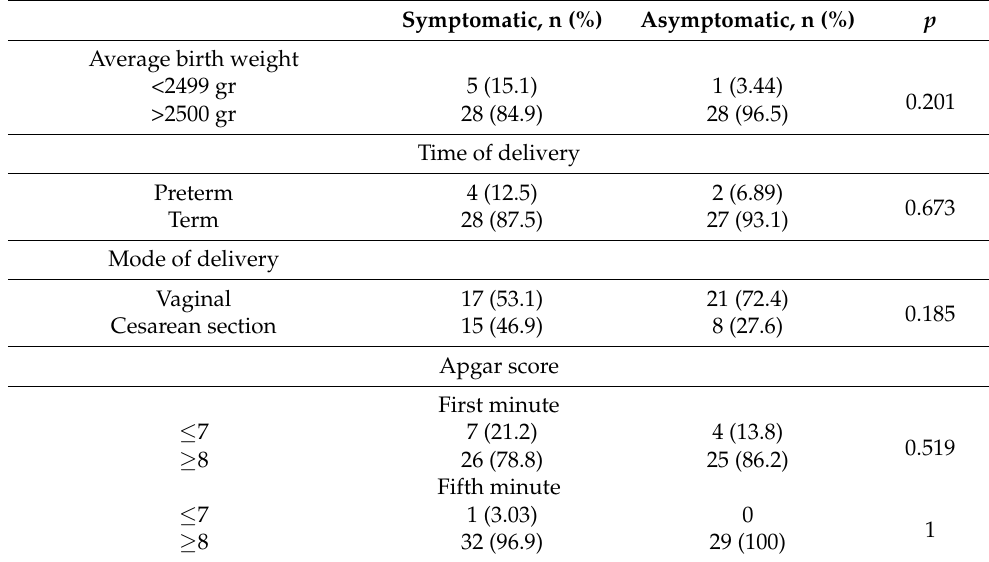
Table 4. Maternal and neonatal outcomes in pregnant women with SARS-CoV-2